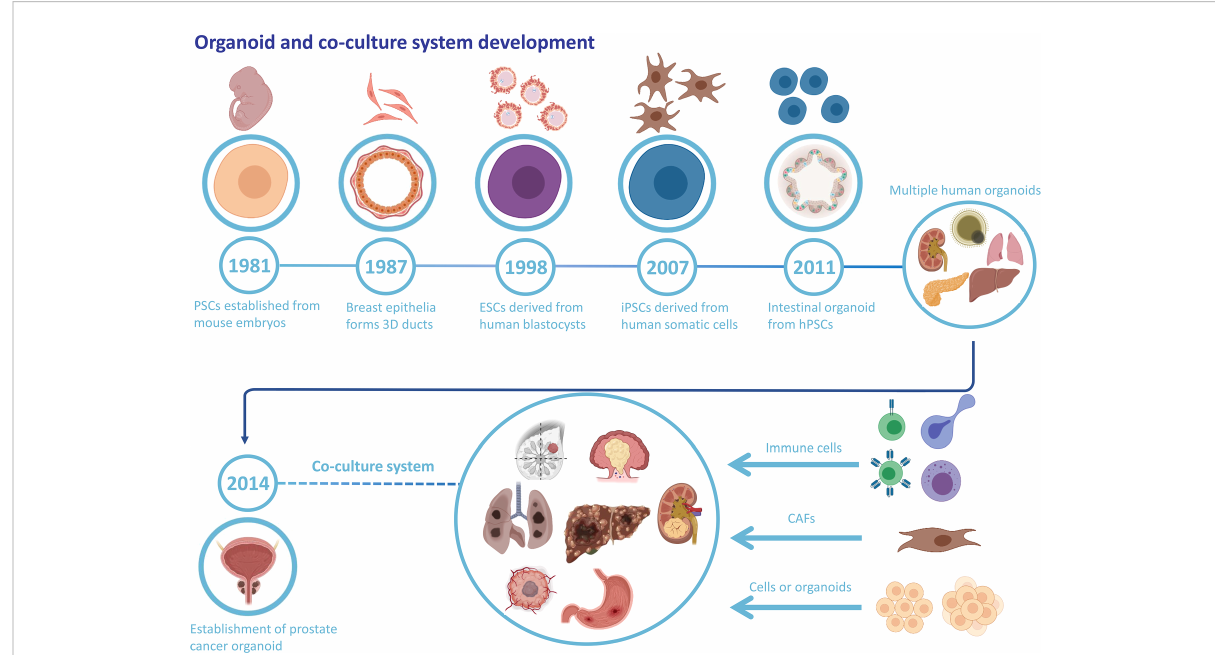
FIGURE 1 Organoid and co-culture system development. The history of organoid and cancer organoids and the well-established co-culture system of various cancer organoids and speci fi c cell